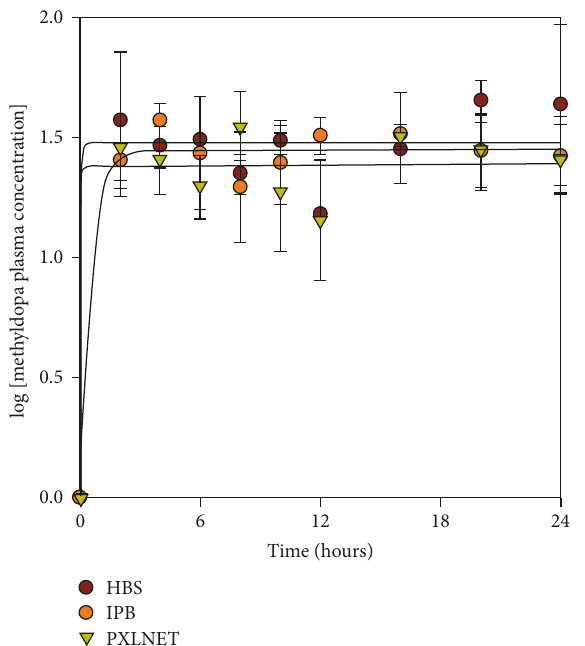
Figure 6: Mean methyldopa plasma concentration after adminis- tration of Madopar HBS capsules and PXLNET and IPB matrices.